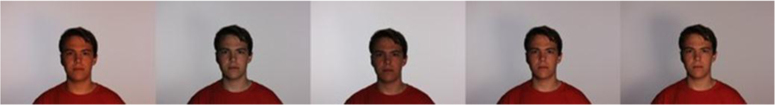
Photos of five different lighting settings were taken at every angle. From left to right: warm, cold, low, medium and high.